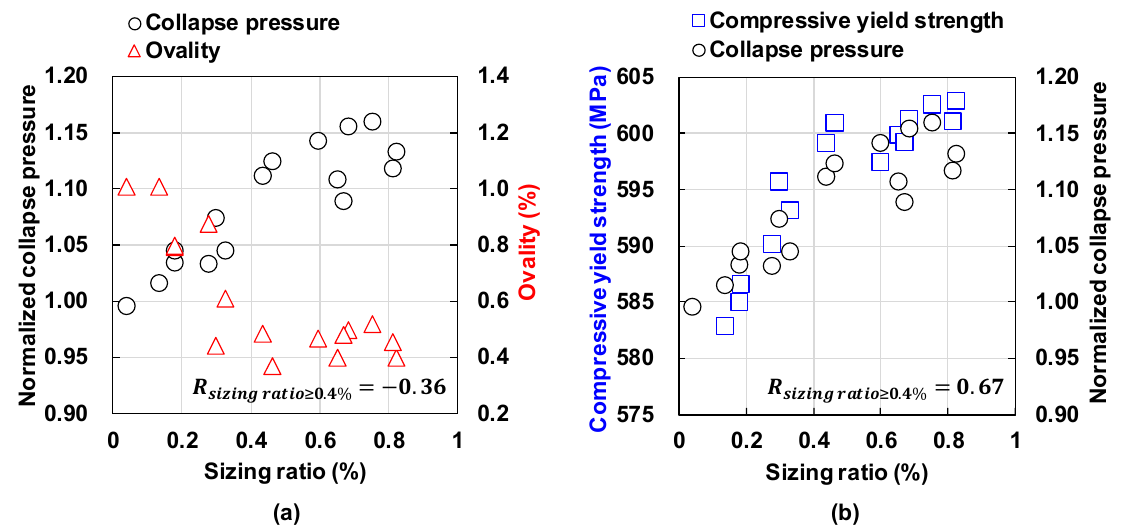
Figure 13. Correlation according to sizing ratio (diameter-to-thickness ratio ( D / t ) = 14) between: ( a ) collapse pressure and ovality; ( b ) compressive yield strength and collapse pressure.